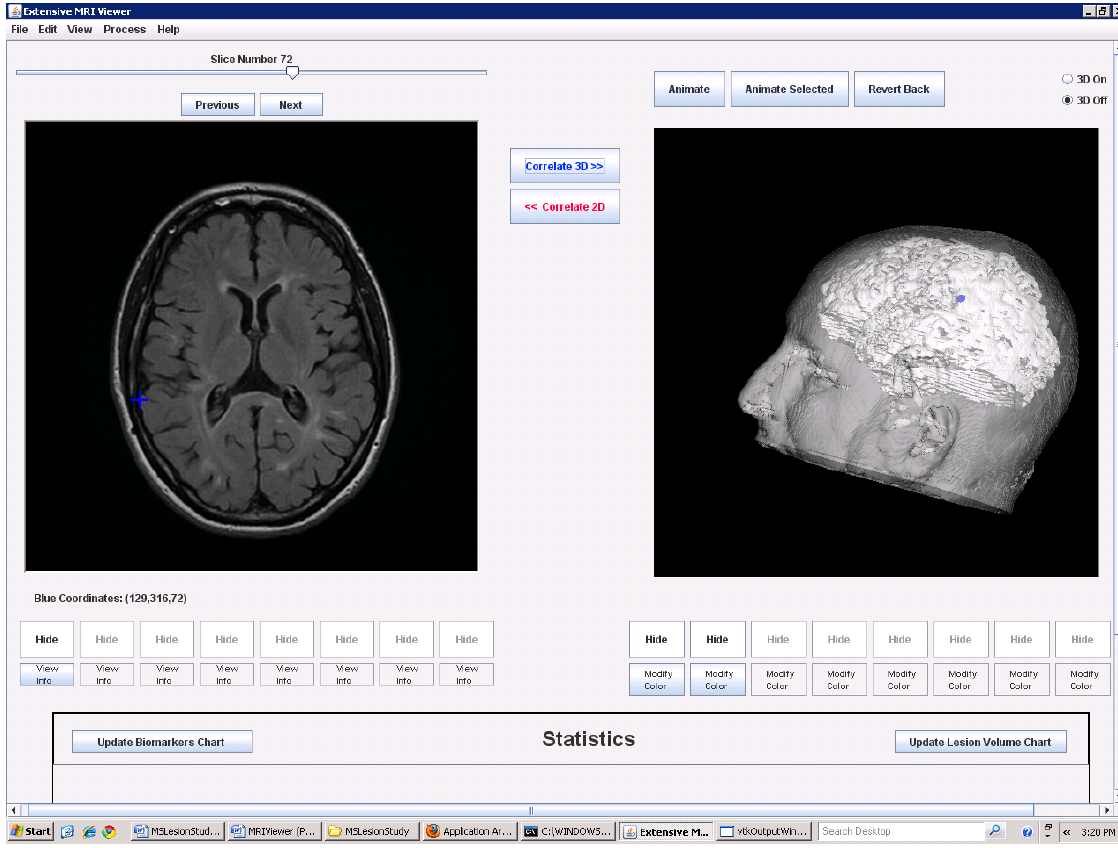
Figure 2: Main frame of the visualization software, which contains a 2D display panel (left), a 3D display panel (right), and a statistical chart display panel